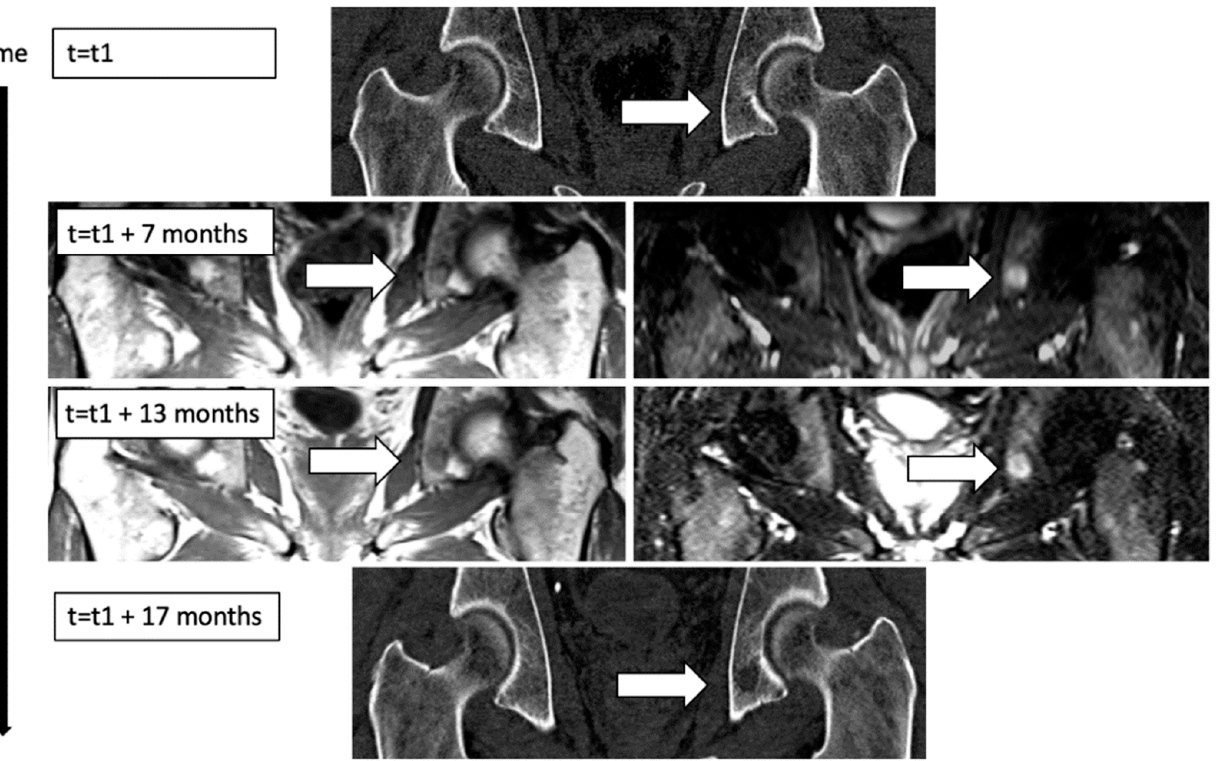
Figure 2. Development of a focal lesion in MRI over time with appearance of a new, corresponding osteolytic lesion in computed tomography (CT) imaging. At initial CT-imaging (t1), trabecular structure of the displayed pelvic and femoral bones was intact. Seven months later, the initial MRI revealed a focal lesion at the left acetabulum (locTV = 1219 mm 3 , upper left (T1w tse) and right (T2w stir)), which then showed a three-dimensional growth dynamic of 3.37 mm 3 /day for 6 months to reach a volume of 1833 mm 3 (t 2 = 13 months, lower left and right). Four months later, the next CT imaging was performed and revealed an osteolytic lesion (t 3 = 17 months, volume = 1022 mm 3 , lower image) in the corresponding